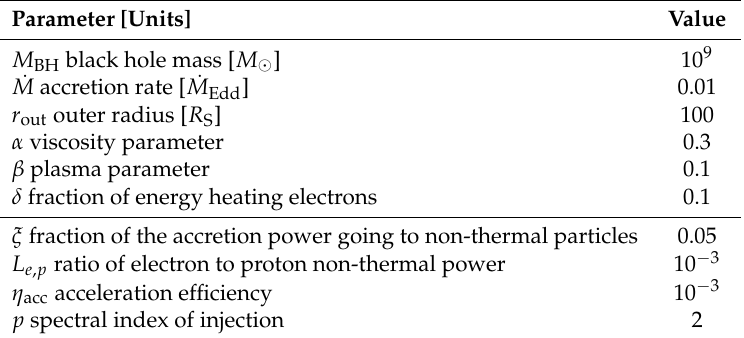
Table 1. Parameters for our fiducial model of a magnetized hot accretion flow. Parameter